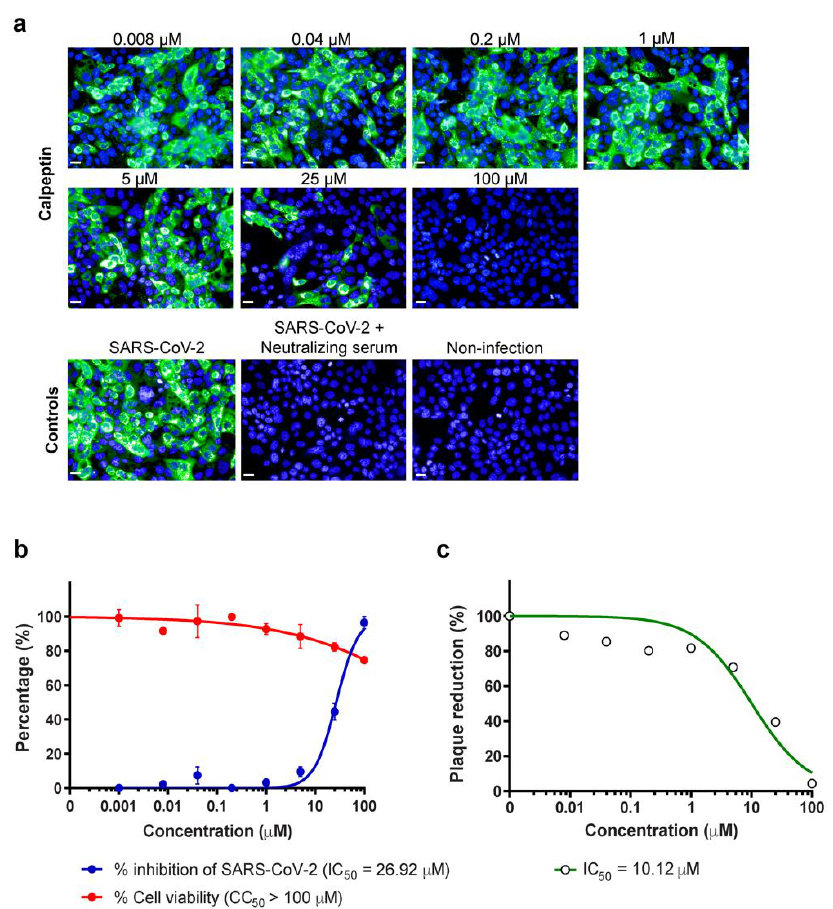
Figure 4. Anti-SARS-CoV-2 activity of calpeptin in human-lung epithelial cells Calu-3. Calu-3 cells were infected with SARS-CoV-2 at 25TCID50 for 2 h and then post-infection treated with calpeptin at concentrations ranging from 0.008 to 100 µ M for 48 h. Positive convalescent serum of a COVID-19 patient was included as a positive control. The supernatant was collected for viral output quantification. The infected cells were fixed and stained for viral nucleoproteins with anti-SARS-CoV NP mAb. The SARS-CoV-2 infected cells were detected by high-content imaging. ( a ) The high-content images of calpeptin treatment in SARS-CoV-2 infected Calu-3 cells are demonstrated. Scale bar: 20 µ m. The percentage of inhibition was calculated as the percentage of the control conditions. The cytotoxicity assay was performed in parallel to evaluate the cell viability at each concentration. The data are presented as the mean ± SEM of three biological replicates. ( b ) The percentage of virus inhibition (blue) and cell viability (red) is shown. ( c ) Viral output was examined by plaque reduction assay, and data are presented as % of the control ( n = 2 biological replicates).